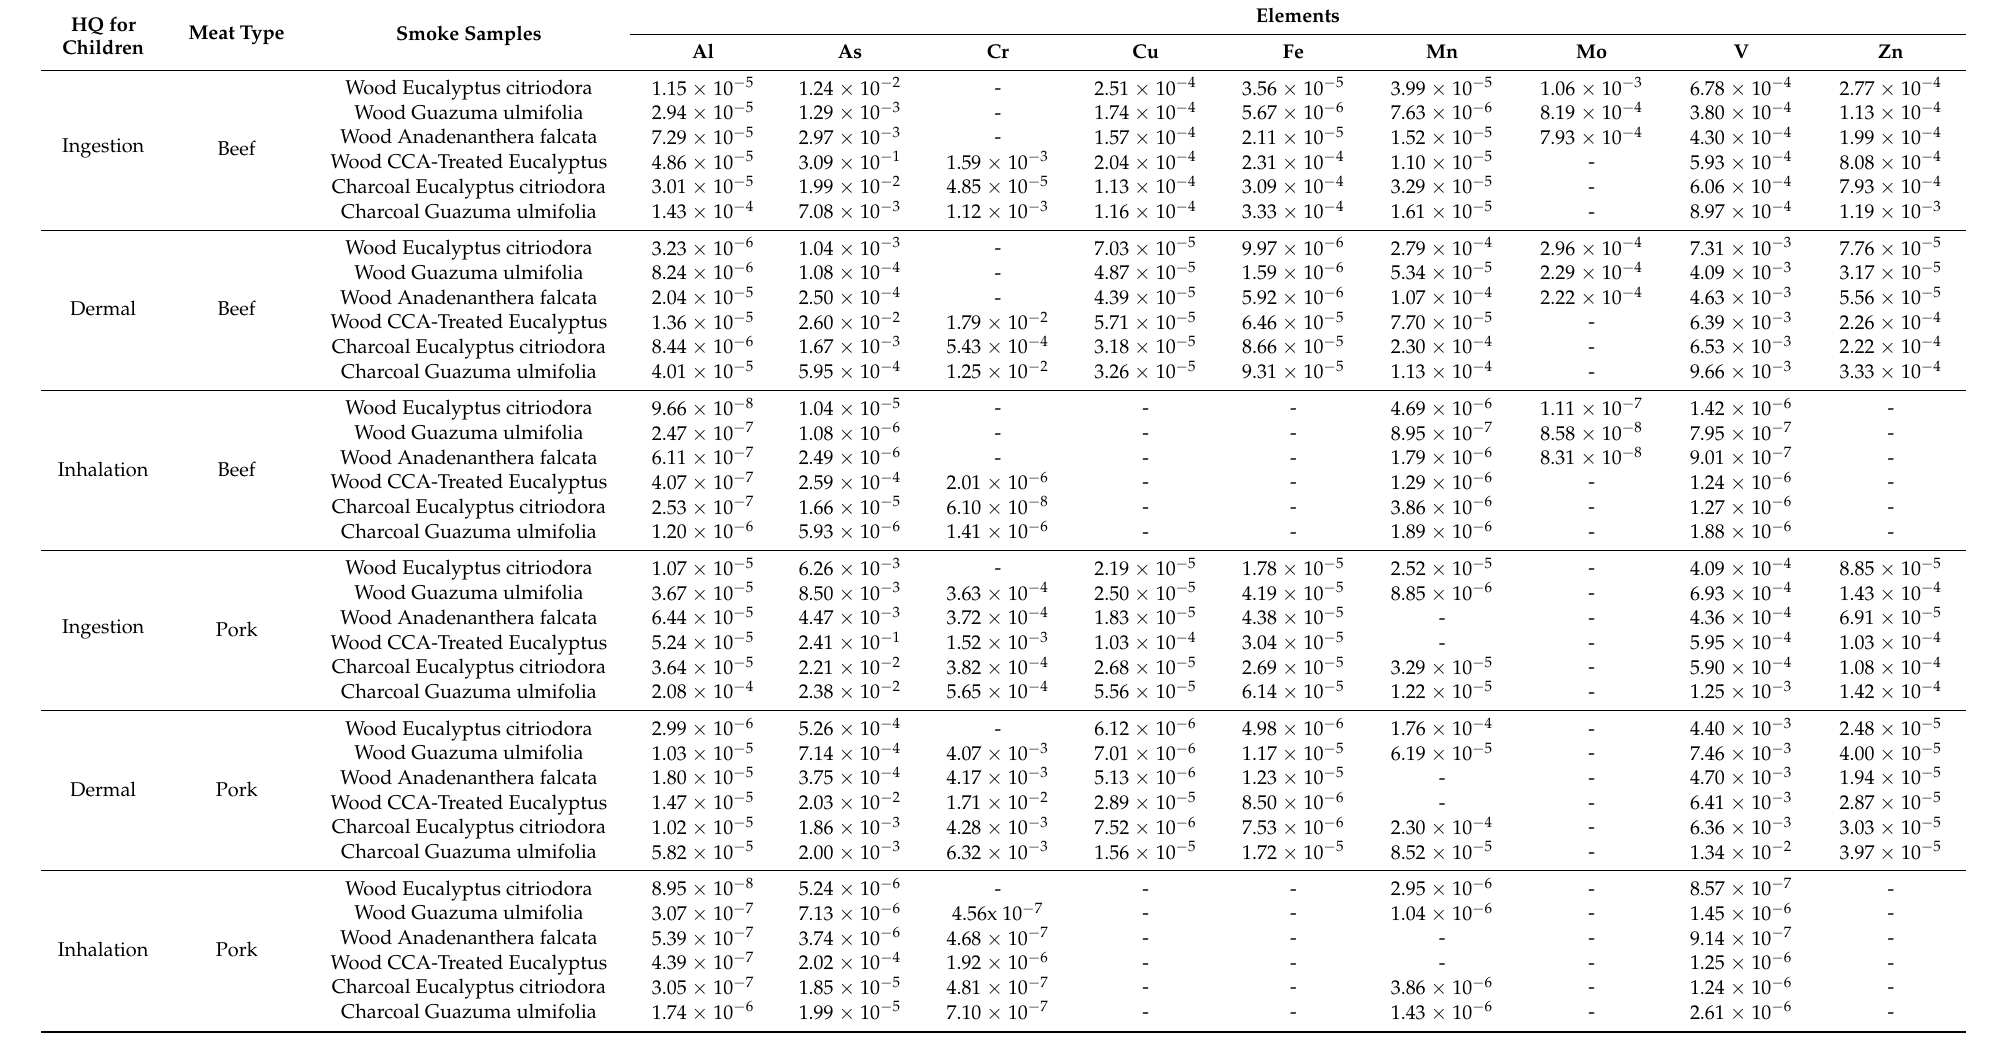
Table 3. Hazard quotient (HQ) values for Al, As, Cr, Cu, Fe, Mn, Mo, V, and Zn in children exposed to smoke via ingestion, dermal contact, and inhalation. HQ for